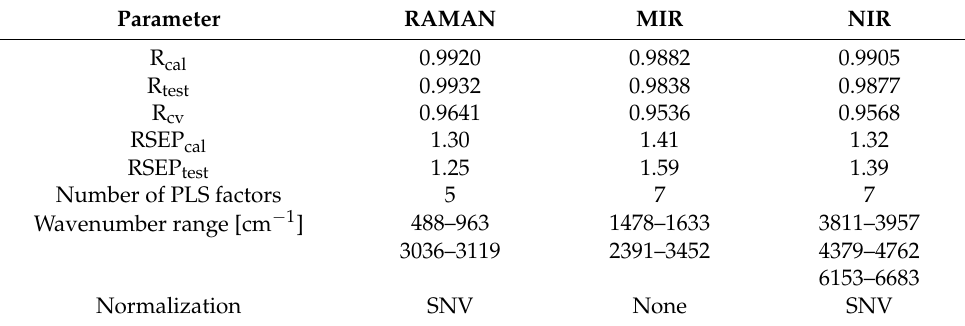
Table 1. Parameters of PLS models developed for Preparation